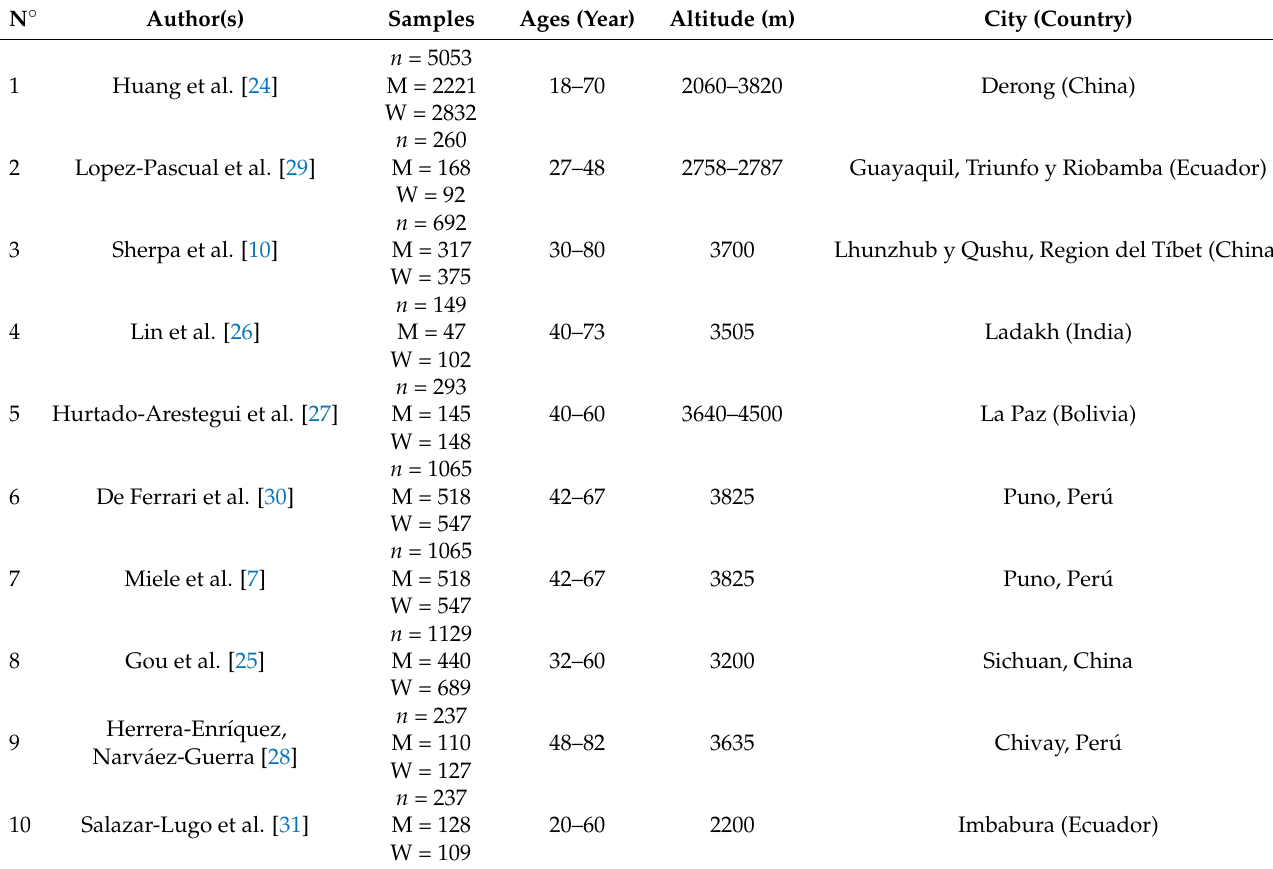
Table 3. Methodological characteristics of research conducted on metabolic syndrome in high- altitude regions.